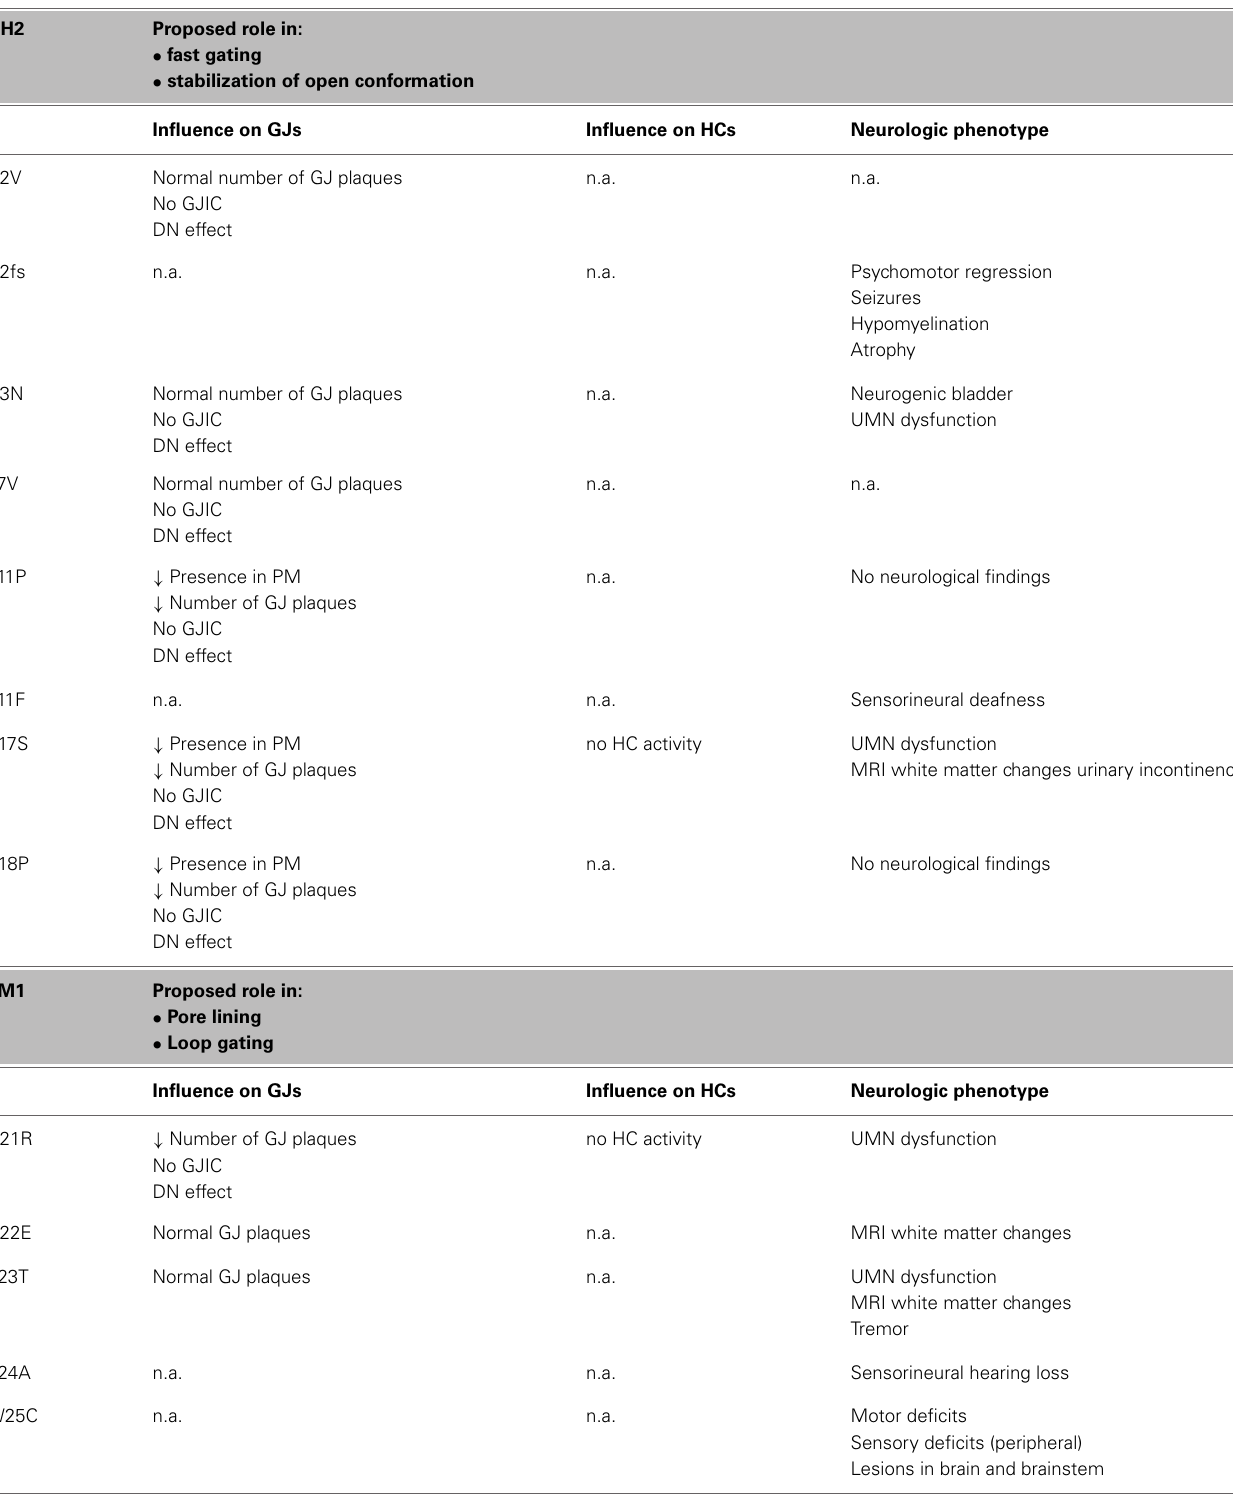
Table 1 | Overview of ODDD-linked mutations in different Cx43 domains, their effect on Cx channel properties and the associated neurologic